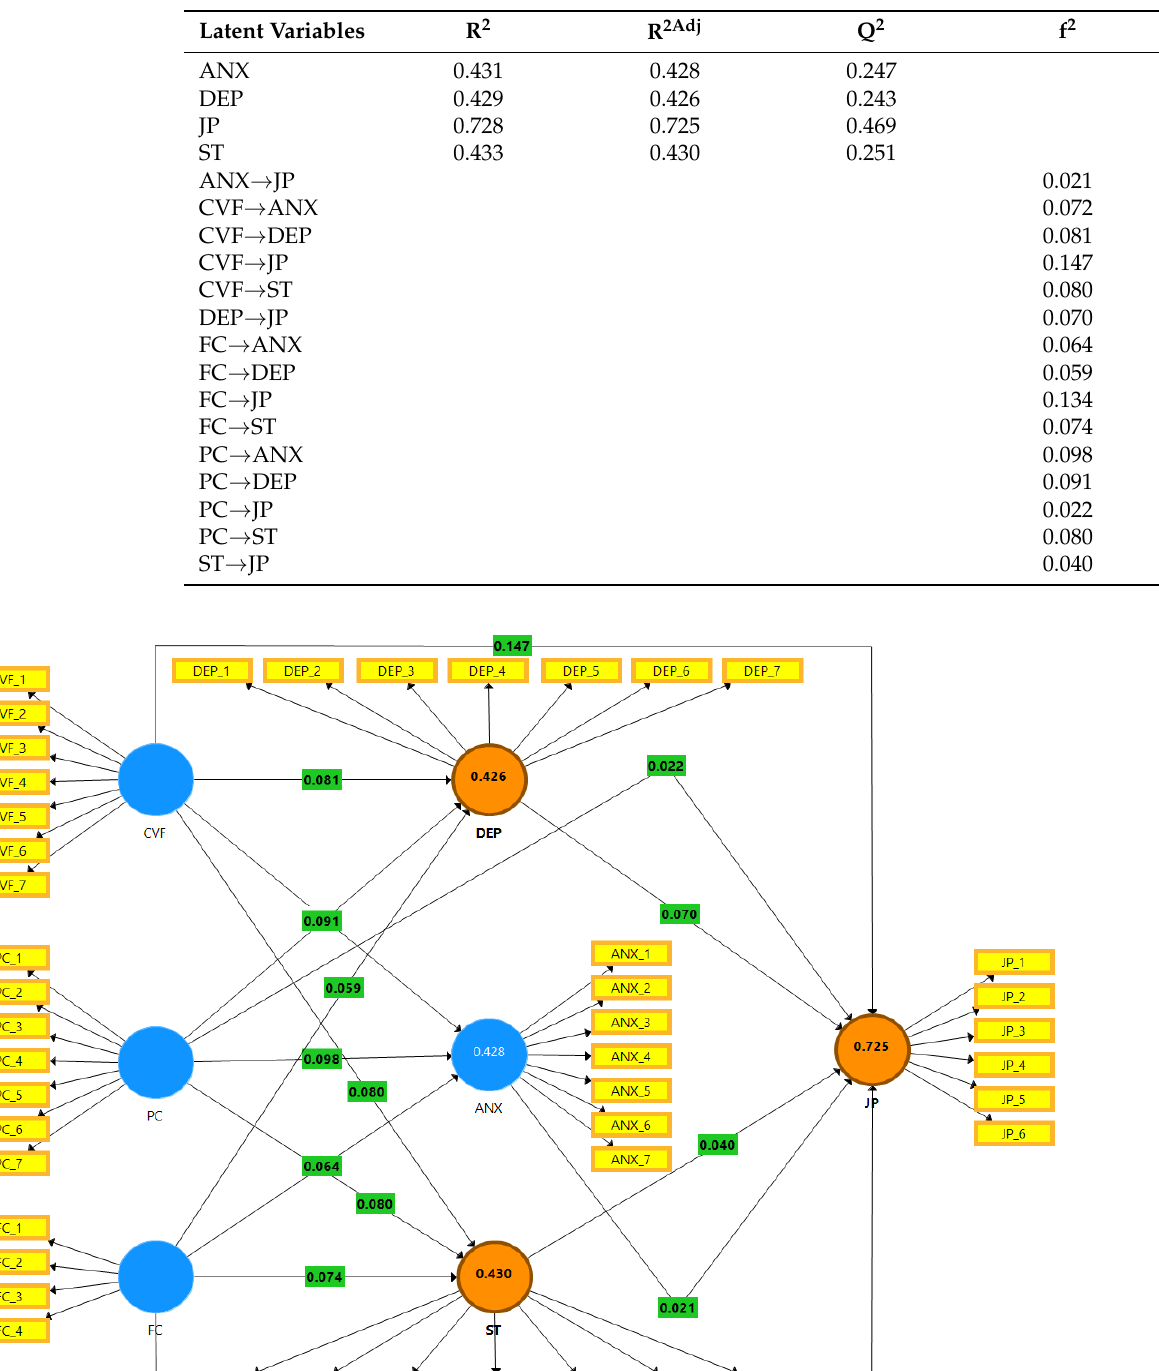
Table 11. Quality Criteria (R 2 , f 2 , and Q 2 ).